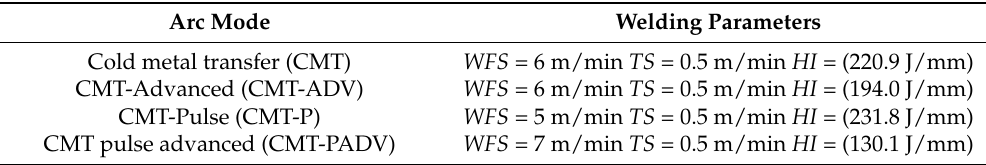
Table 2. Parameters for 2219-Al wall fabricated by four arc